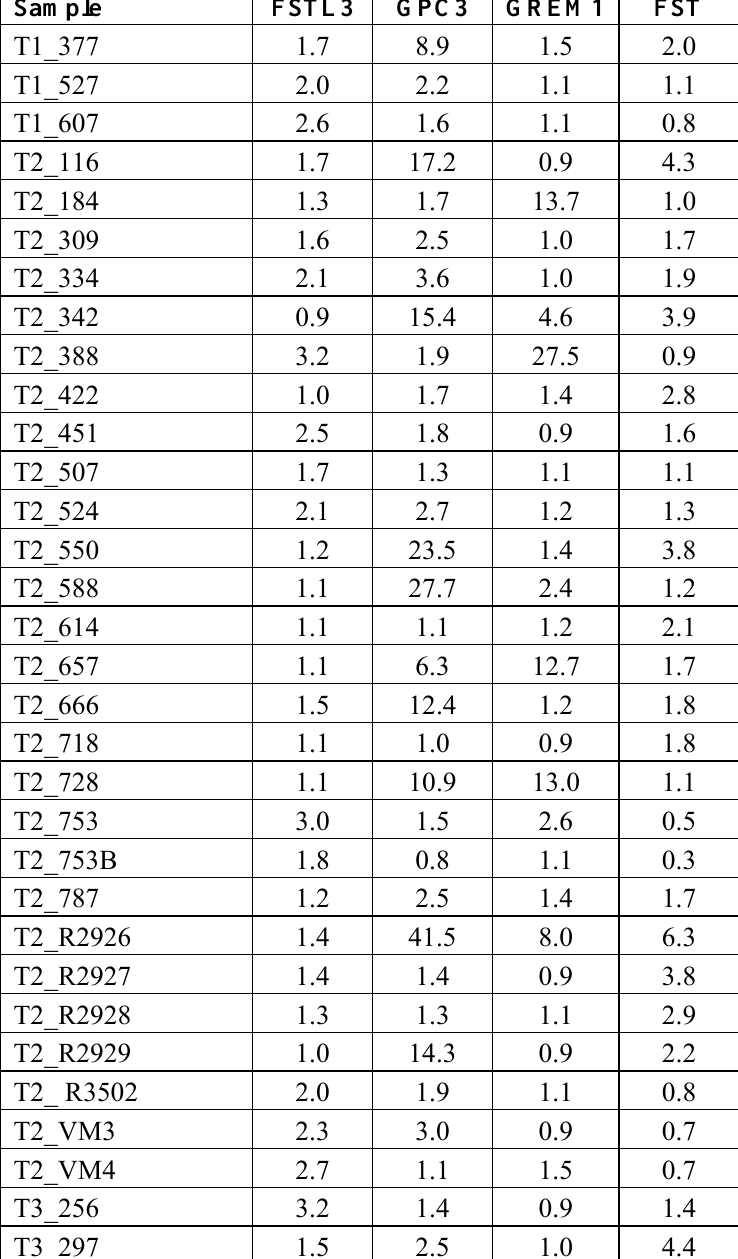
Table S3. Individual fold-change for BMP inhibitors in HCC